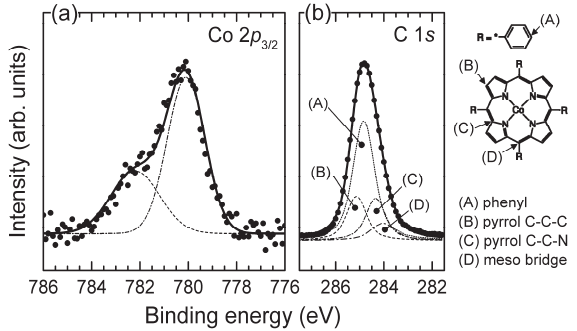
Fig. 3. Lineshape analysis of (a) the Co 2 p 3/2 spectrum and (b) the C 1 s spectrum related to the 8 ML CoTPP film (see the caption of Fig. 2 for more details). A schematic is added illustrating the contribution of different C species to the overall C 1 s lineshape.